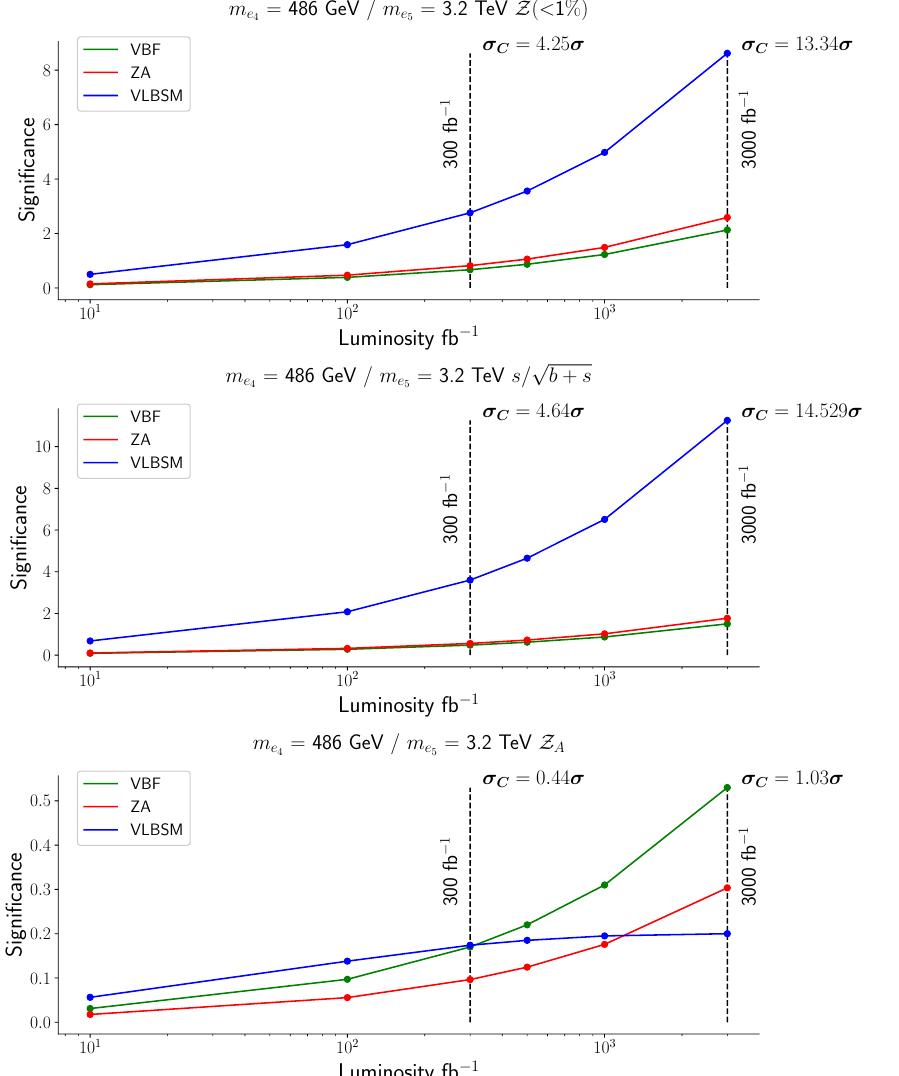
Figure 18. The same as in figure 17 but for a lightest VLL mass m = 486 GeV